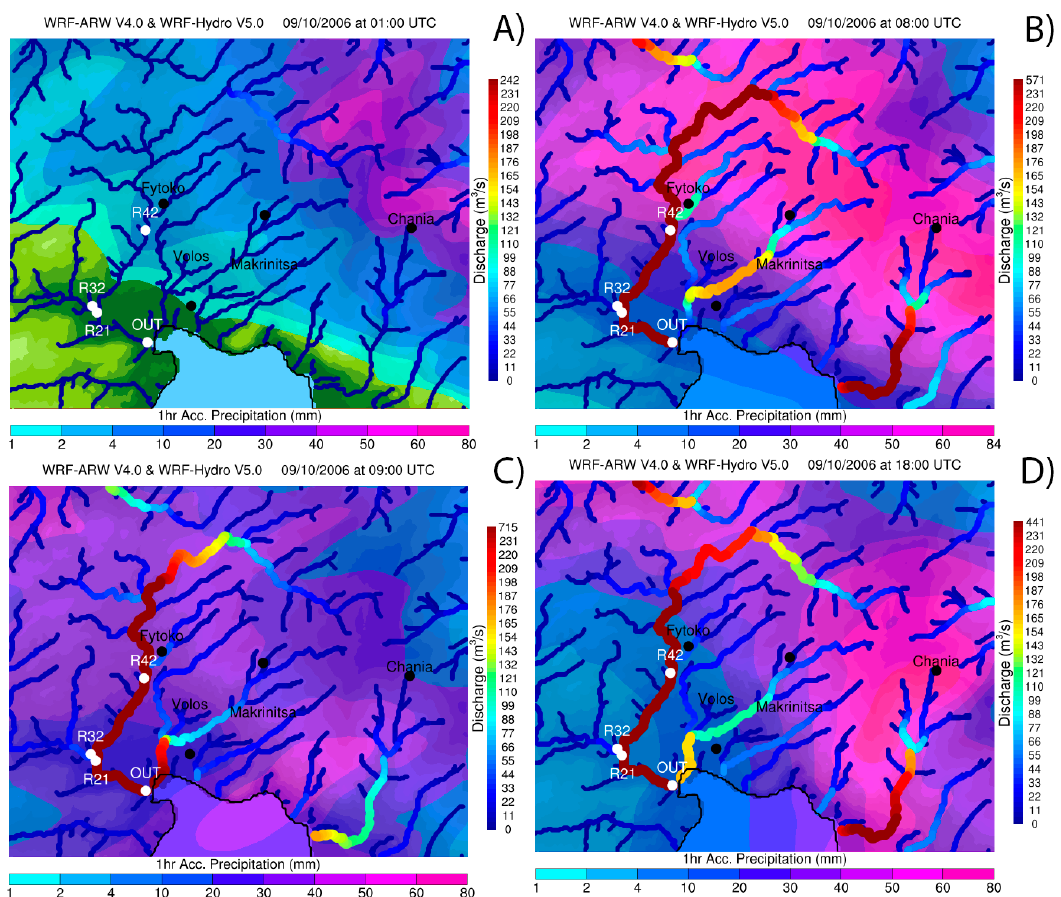
Figure 7. Discharge (m 3 s − 1 ) simulated by the WRF-Hydro model superimposed by the corresponding 1-h accumulated precipitation (mm) simulated by the WRF-ARW model at ( A ) 01:00, ( B ) 08:00, ( C ) 09:00, and ( D ) 18:00 UTC of 9 October 2006.